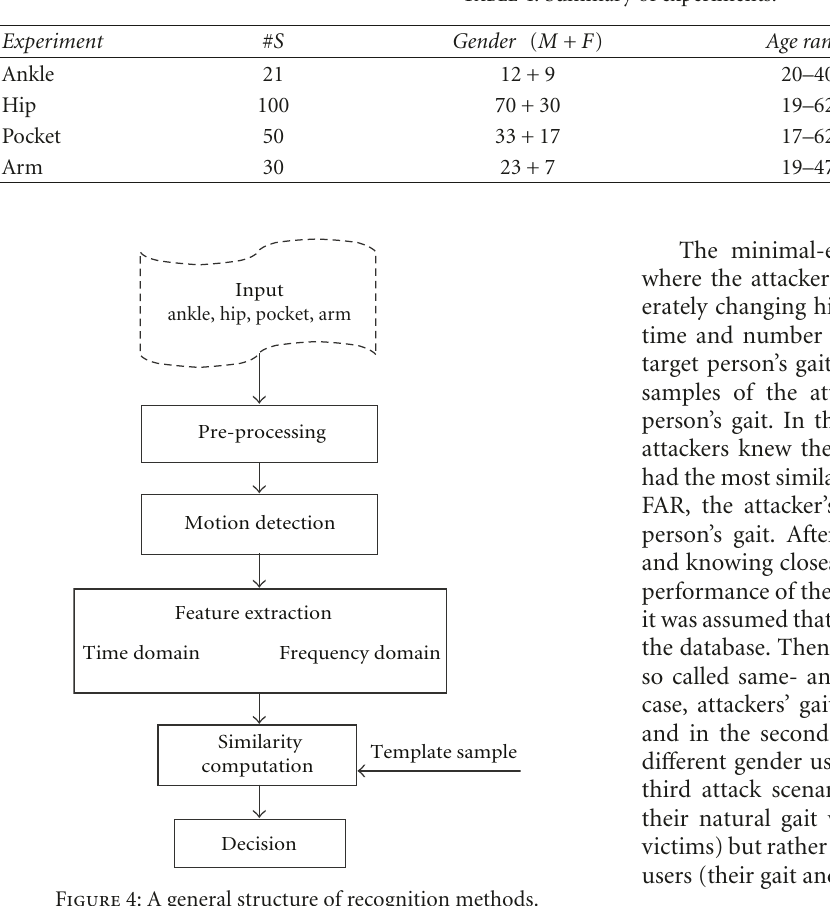
Table 4: Summary of experiments.